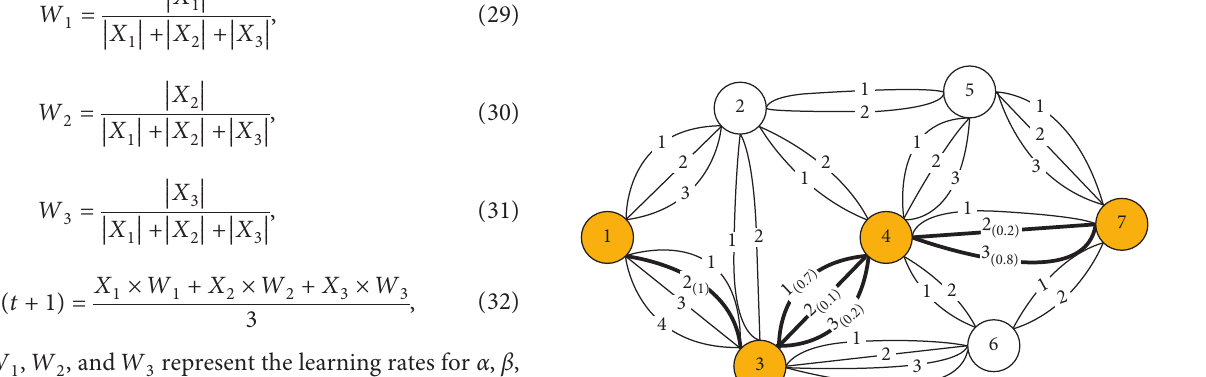
Figure 4: The update mode of transportation plan.